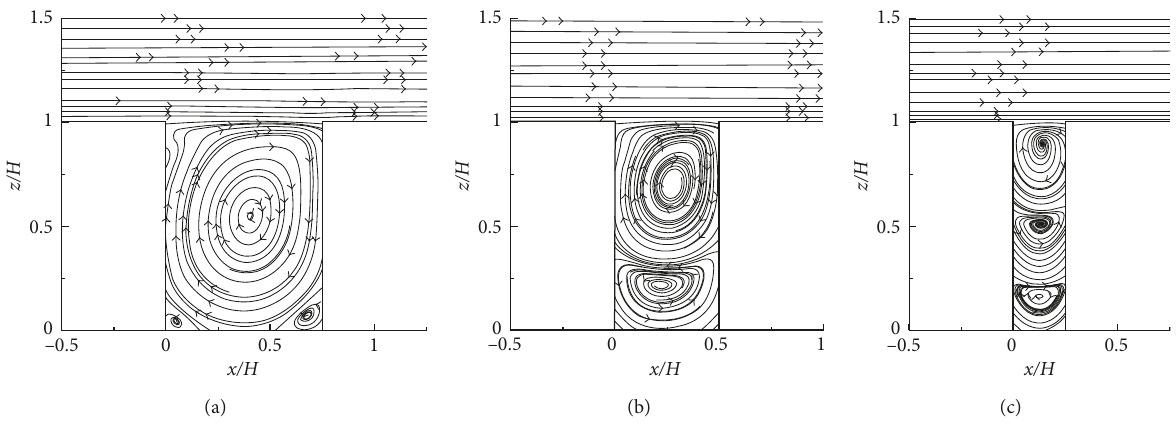
Figure 9: Streamlines of the simulated velocity magnitude for AR